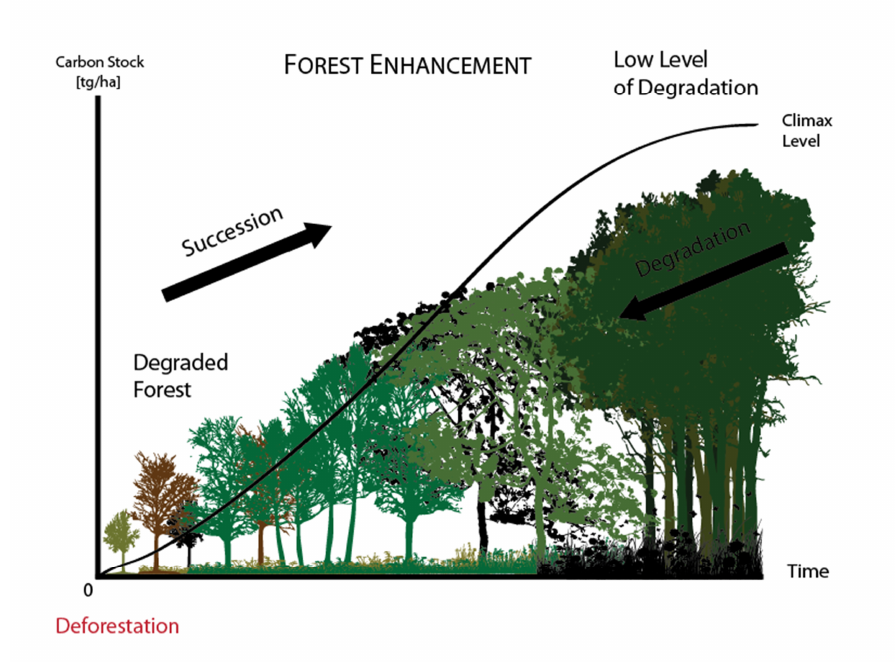
Figure 1. Forest succession curve (modified from Eckert et al .